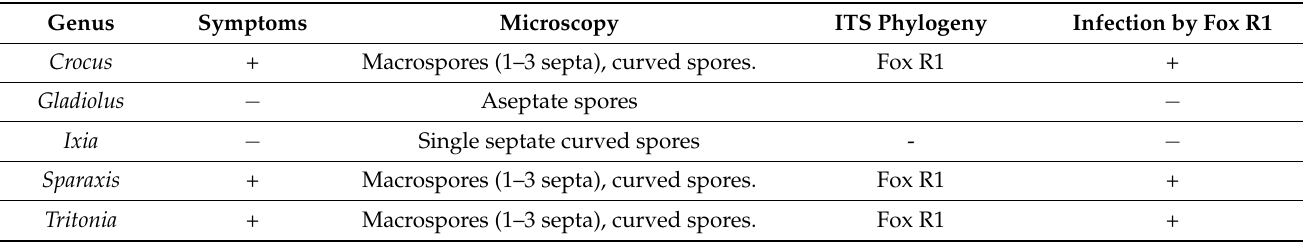
Table 3. Disease assays of Fox R1 were conducted on four other members of the family Iridaceae